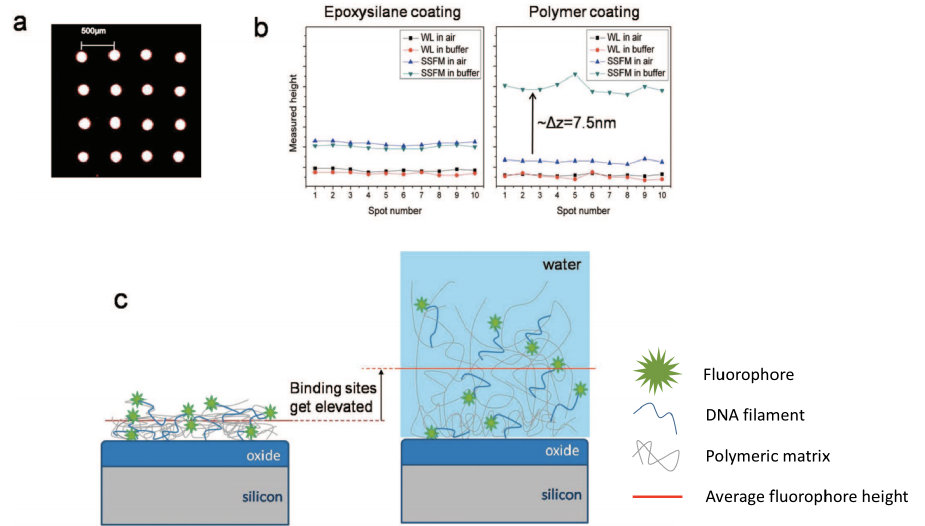
Figure 3. ( a ) Fluorescence scan of a typical array of ssDNA spots on copoly(DMA-NAS-MAPS). The spots are ≈ 150 µ m in size with 500 µ m pitch. ( b ) Detected heights with WL and SSFM techniques for 10 different spots on the same sample before andafter hydration. The epoxysilanized sample shows no change in White Light reflection spectroscopy (WL) and Self-Interference Fluorescence Microscopy (SSFM) levels before and after hydration. For the polymer coated sample, the WL level is maintained upon hydration, whereas the SSFM level increases by ≈ 7.5 nm. ( c ) Illustration of the justification for the height change in probe heights immobilized on the polymer. The polymer swells upon hydration, resulting in elevation of the binding sites. Figure adapted from with permission from [68]. Copyright (2009) American Chemical